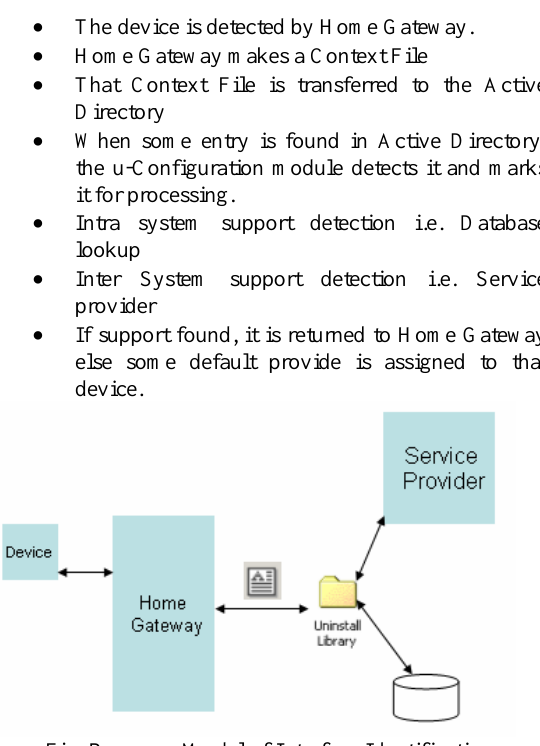
Fig: Resource Model of Interface